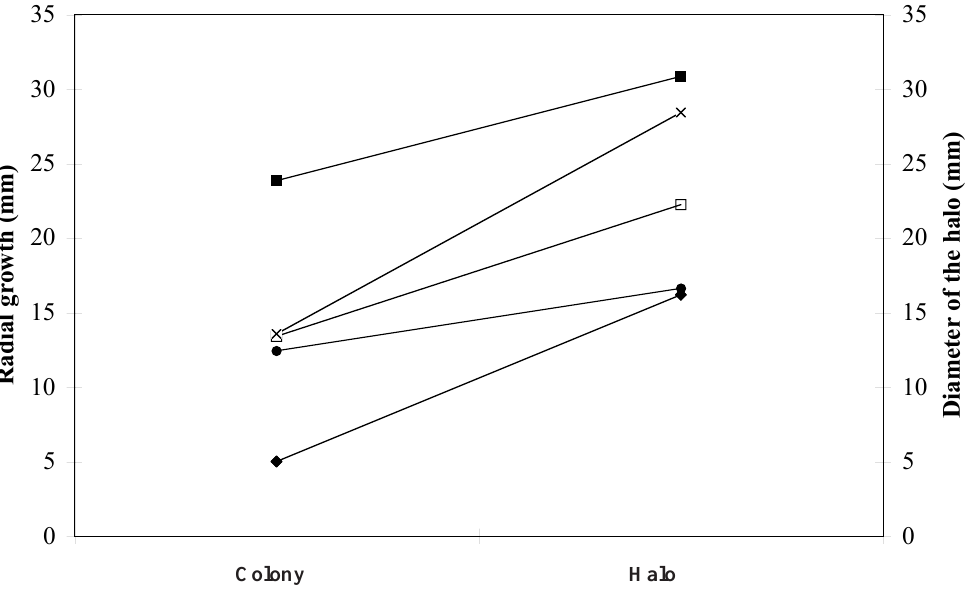
Fig. 1. Clustering of 7 days old colonies of Phaeomoniella chlamydospora , Phaeoacremonium aleophilum and P. rubrigenum grown on Medium 1 (EPA without CaCl and with sodium salt of polygalacturonic acid as sole carbon 2 source, pH 5) considering the mean diameter of the colony (colony) and the mean diameter of the halo (halo) after flooding with 1% CTAB. SE<0.76 mm for all colonies and halos. K-Means Clustering partitioning method was em- ployed with a final required number of clusters equal to five. Colony: F4,12=35.8; P <1.4*10-6; halo: F4,12=56.30; P <1.12*10-7. Cluster 1 ( (cid:1) ): Pal 89; cluster 2 ( (cid:2) ): Pch 29, 34, 52, 46; cluster 3 ( (cid:3) ): Pch 16, 24, 27, 30, 11, 19, 28, 17 and Prubr 125; cluster 4 ( x ): Pch 55; cluster 5 ( (cid:4) ): Pal 72,